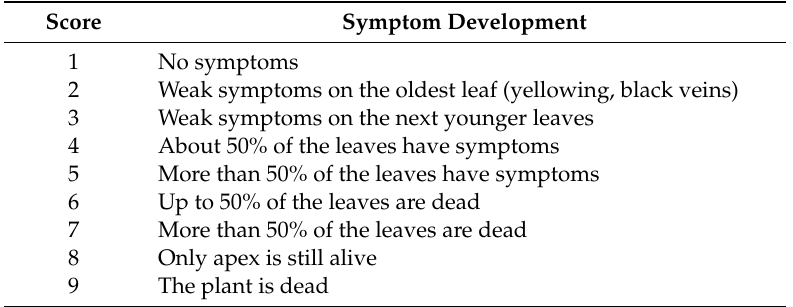
Table 2. Assessment key for scoring foliar symptoms induced by V. longisporum on Brassica species inoculated with the root dip method.